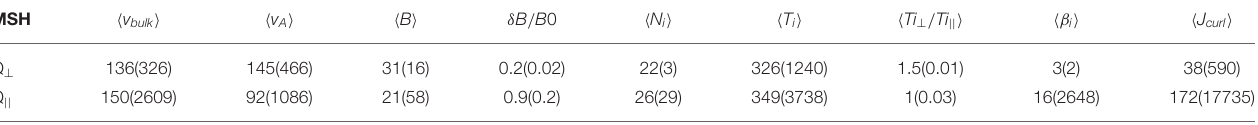
TABLE 1 | Averaged parameters and the respective variance (gray) for quasi-perpendicular (Q ⊥ ) and (Q || ) MSH.